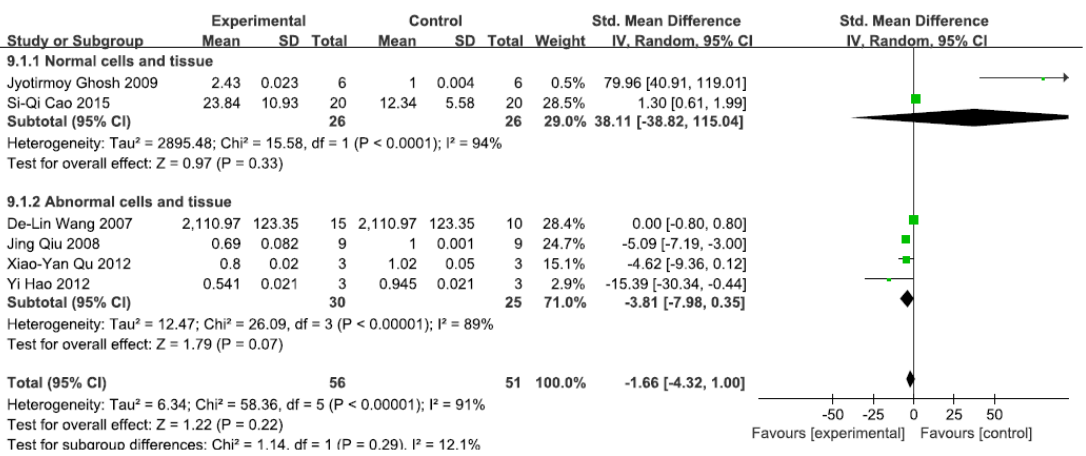
Figure 6. Effects of arsenic on inhibitor of kappa B kinase(IKK). Forest plot showing the impact of arsenic treatment on IKK compared with controls. Abbreviations: SMD = standardized mean difference, IV = independent variable, 95% CI = 95% confidence interval.